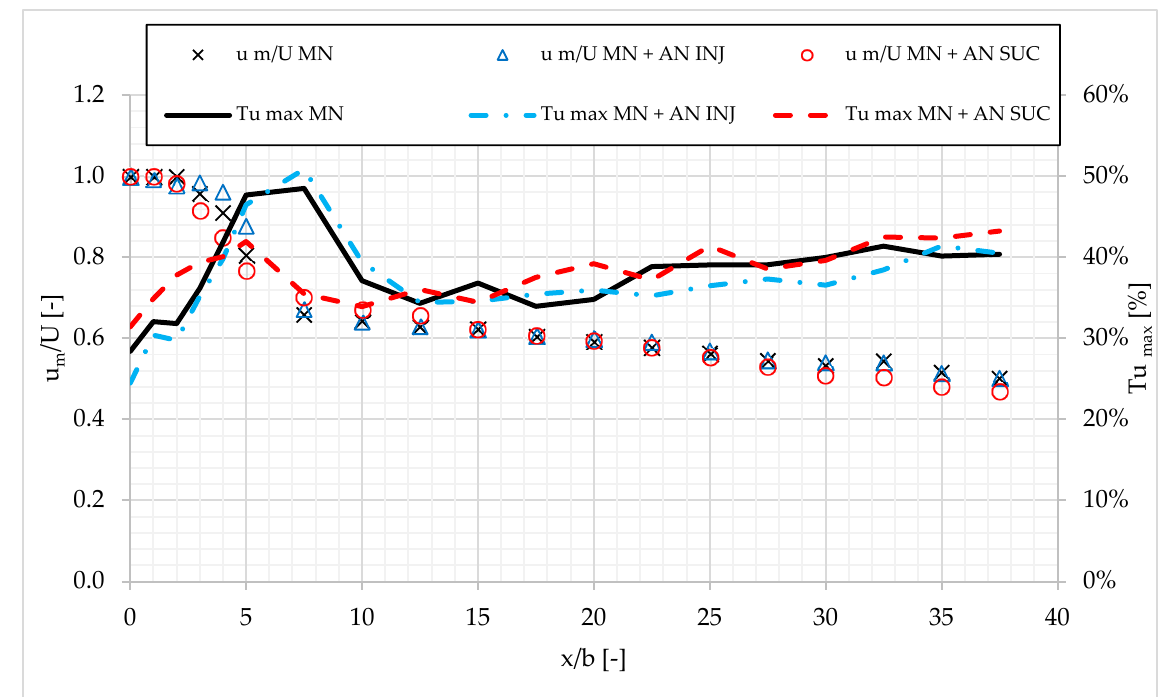
Figure 6. Maximum average velocity u max and maximum turbulence Tu max in each measurement plane.